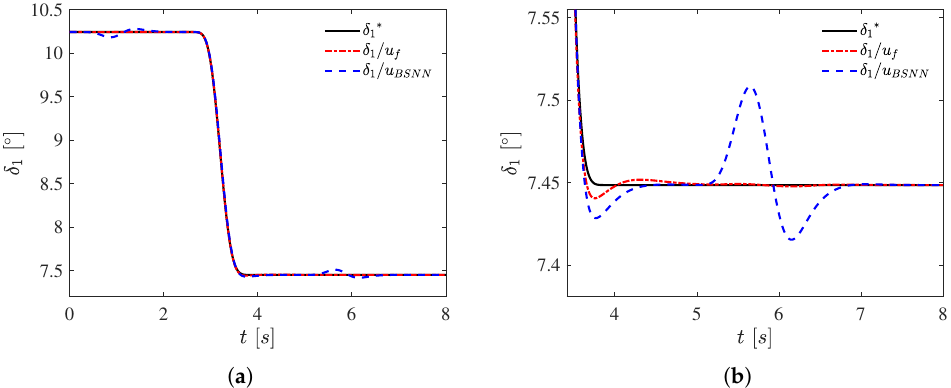
Figure 13. Load angle of generator 1 of two interconnected power systems: ( a ) δ 1 ; ( b ) zoom of δ 1 .